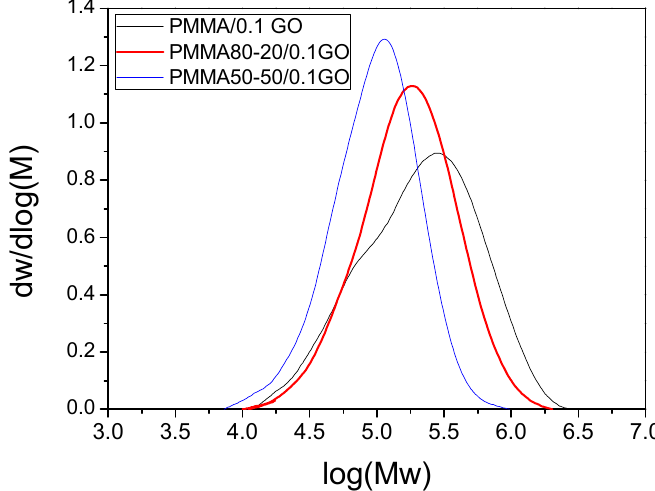
Figure 7. Full Molecular weight distribution of neat PMMA obtained after bulk and solution polymerization.